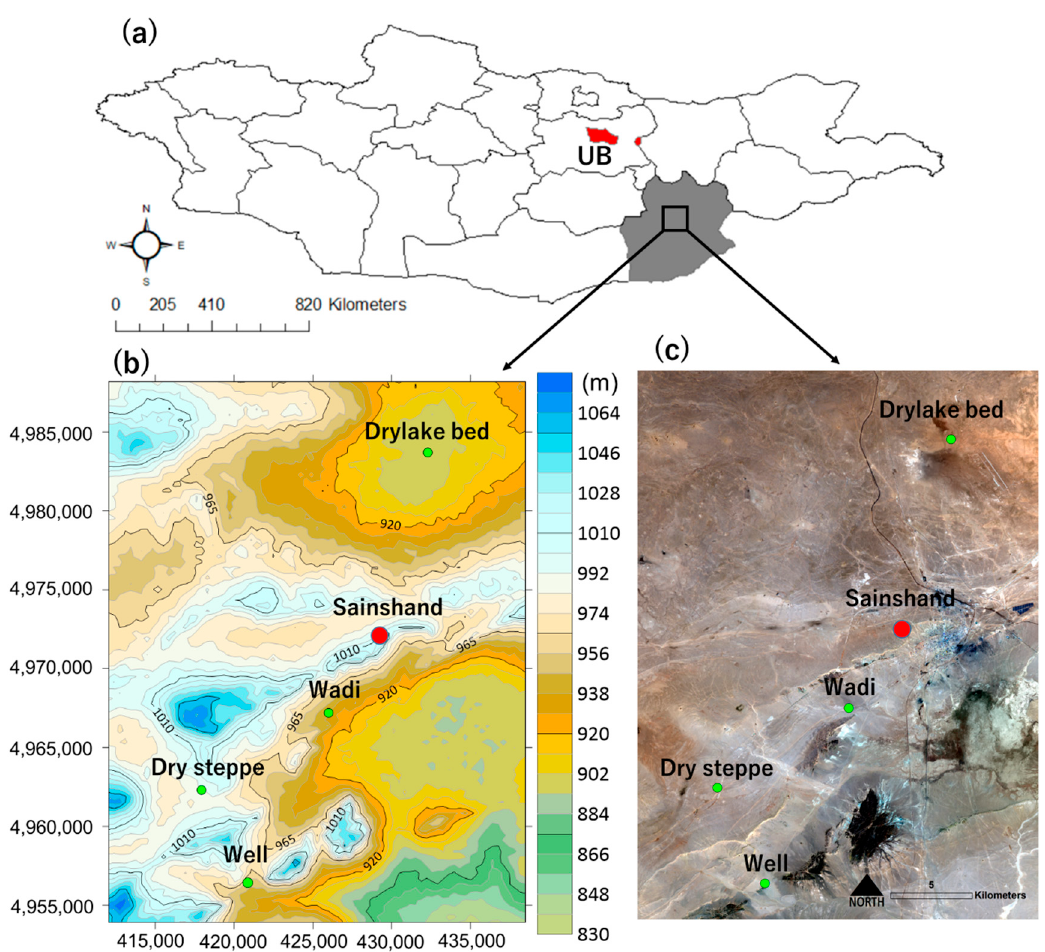
Figure 1. Geographical location of the study area. The sample site on the west side of the investigated dust source in Mongolia is shown on the map. The study site is a terrain with an elevation ranging from 1311 m to 692 m, with four sample points: dry lake bed, desert steppe, wadi, and well. ( a ) Map of Mongolia. ( b ) The topographic contours of the study site DEM (Digital Elevation Model data sources are from SRTM (The Shuttle Radar Topography Mission); the spatial resolution is 1 arc-second for global coverage, download from © USGS Earth Explorer; and topographic contour (TC) files were made using Surfer, Golden Software ® ). The values on the vertical and horizontal axes indicate distances (m) on UTM (Universal Transverse Mercator) North 48 zone and the World Geodetic System (WGS) 84 projection. ( c ) The sampling points on Sentinel 2 satellite imagery (The Copernicus Sentinel-2 mission data download from The Copernicus Open Access Hub. R-G-B color composition used band4 (red), band3 (green), and band2 (blue) of Sentinel 2 imagery; the spatial resolution is 10 m)